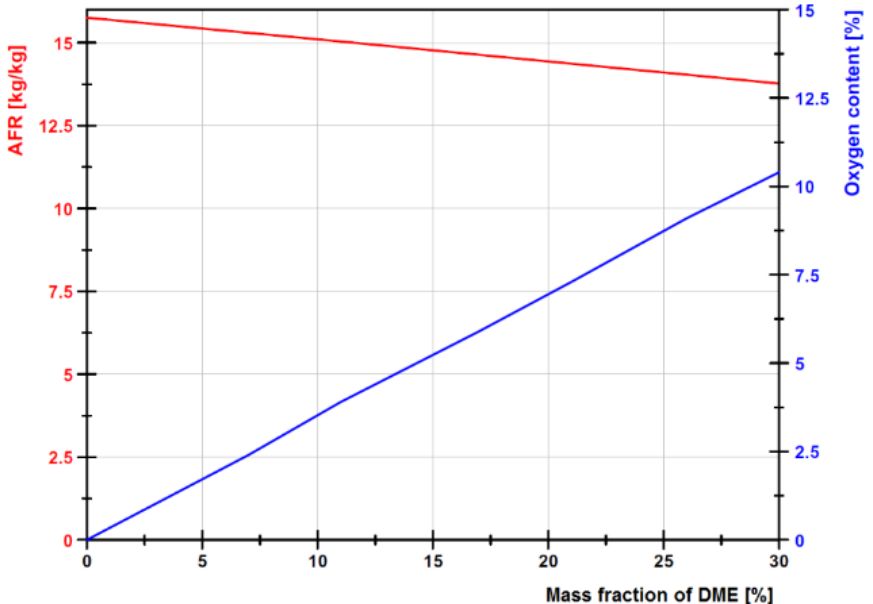
Figure 5. Stoichiometric air–fuel ratio (red line) and oxygen contents (blue line) for different LPG + DME mixtures.